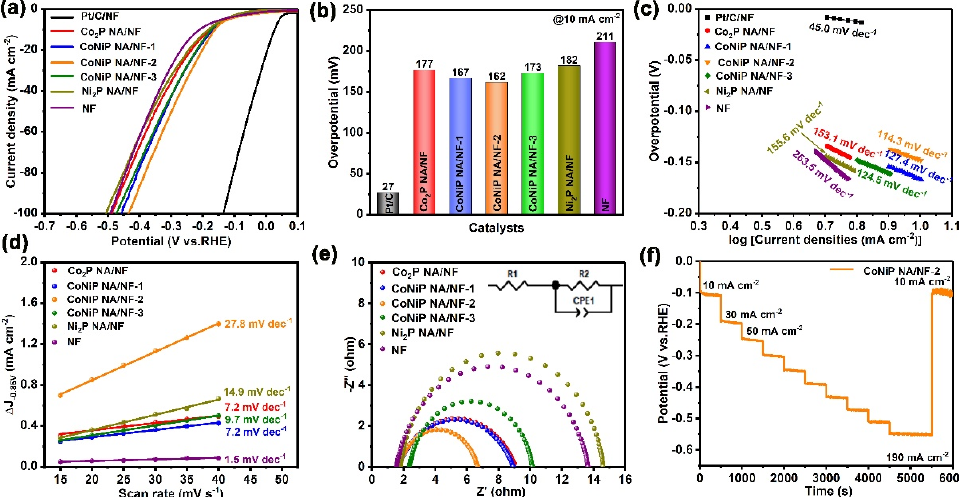
Figure 5. The HER catalytic performances of samples in 1.0 M KOH. ( a ) HER polarization curves over the various samples at a scan rate of 5 mV s − 1 . ( b ) The corresponding overpotentials at the current density of 10 mA cm − 2 . ( c ) The corresponding Tafel slopes. ( d ) The plots of the current density versus the scan rate for the catalysts. ( e ) The Nyquist curves of the obtained catalysts (the inset is the equivalent circuit). ( f ) Multi-current step chronopotentiometric